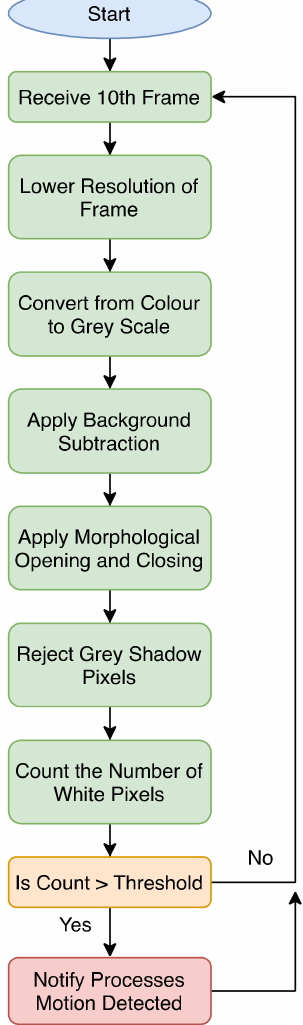
Figure 2. Motion detection